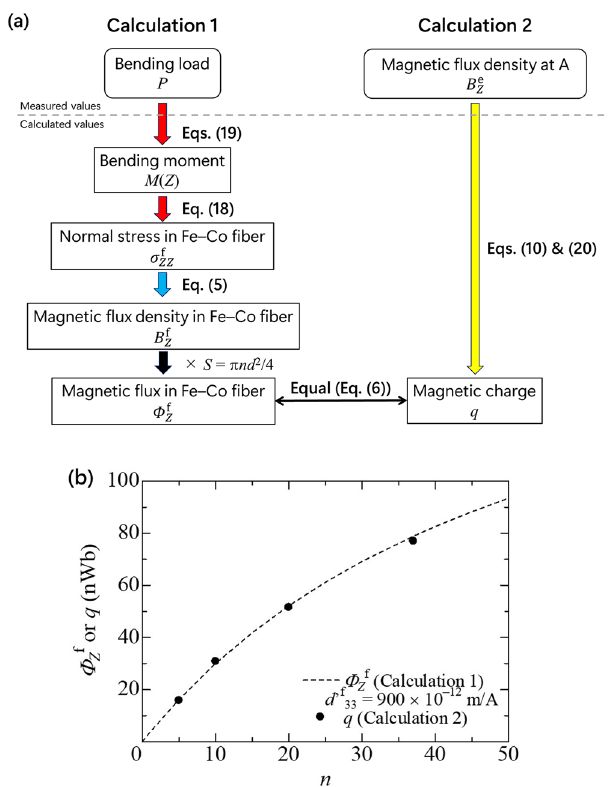
Figure 11. ( a ) Scheme of estimation of magnetic flux in Fe–Co fibers, and ( b ) magnetic flux versus the number of Fe–Co